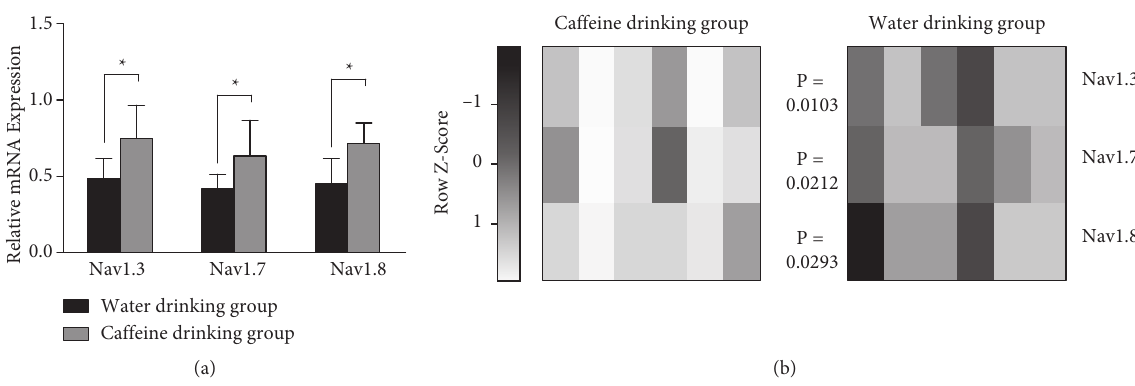
Figure 4: Expression of pain-related voltage-gated sodium channel genes. (a) Relative mRNA expression of pain-related voltage-gated sodium channels, including the Nav1.3, Nav1.7, and Nav1.8. (b) Grayscale heat map generated using the online heatmapper [12] showing the distribution of Nav1.3, Nav1.7, and Nav1.8 mRNA expression levels as Z-scores for each animal in the water drinking group and caffeine drinking group. P values of the two-tailed paired t -test are reported. Differences were considered significant for p values < 0.05 ( ∗ ) .